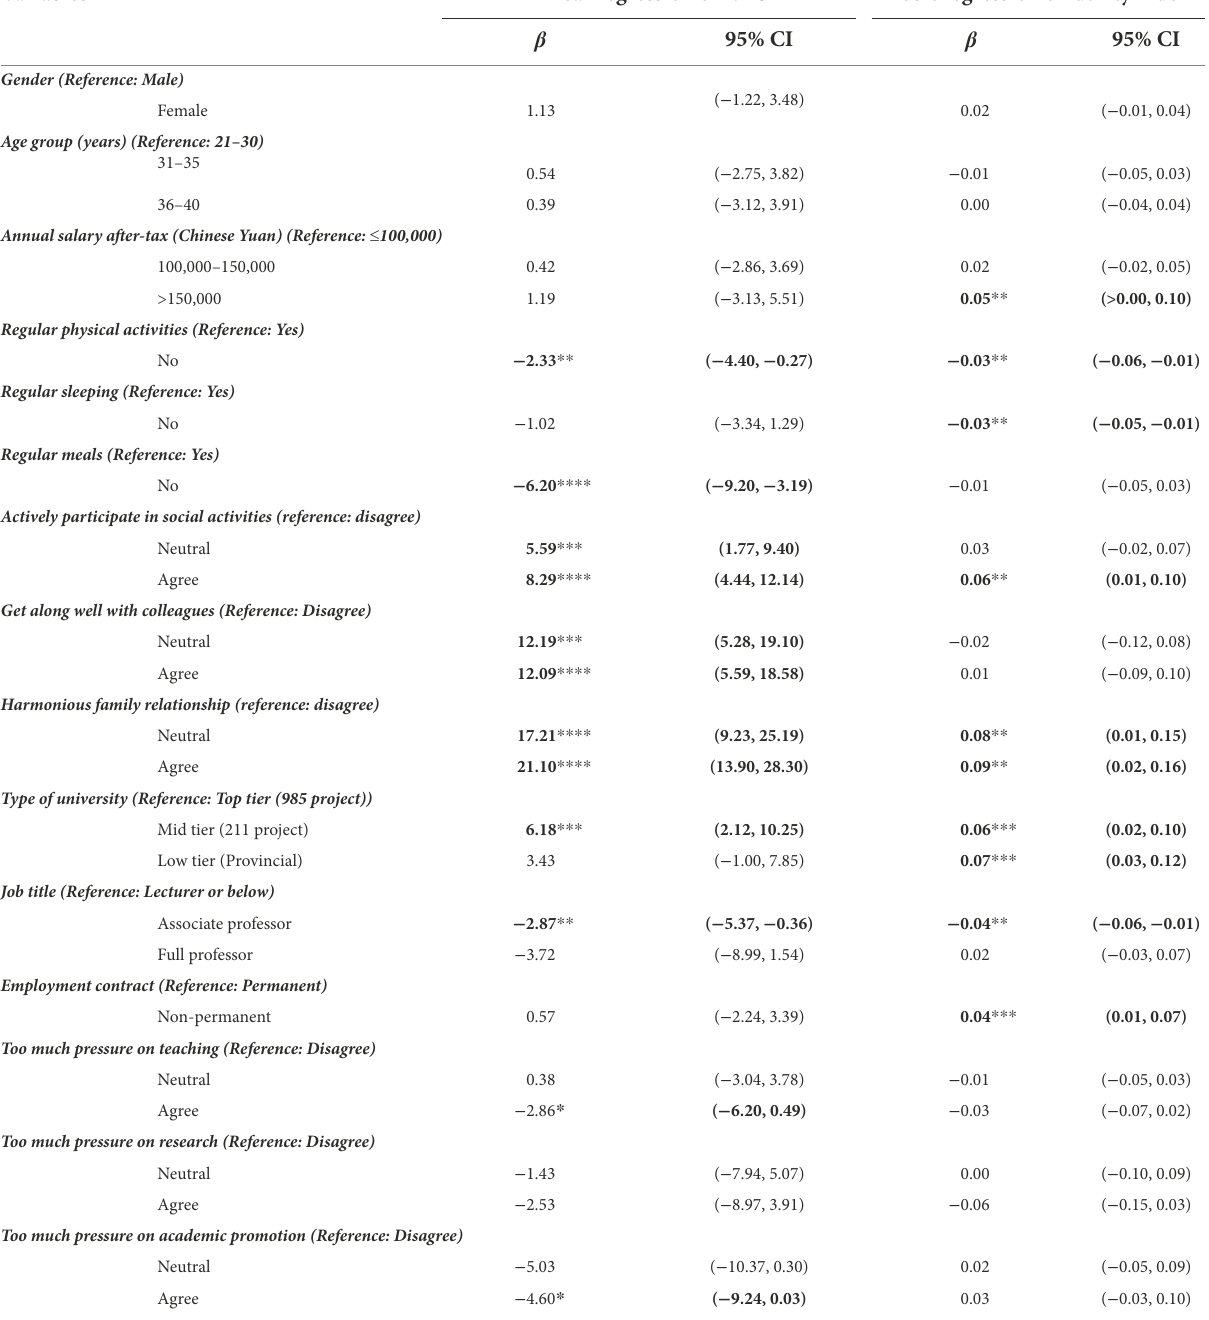
TABLE 3 Predictors of VAS and utility index scores: results of single-level linear and Tobit regression models. Variables Linear regression on VAS Tobit regression on utility